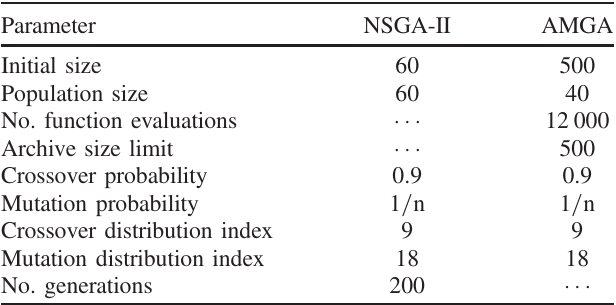
TABLE II. Baseline algorithm parameter selections.